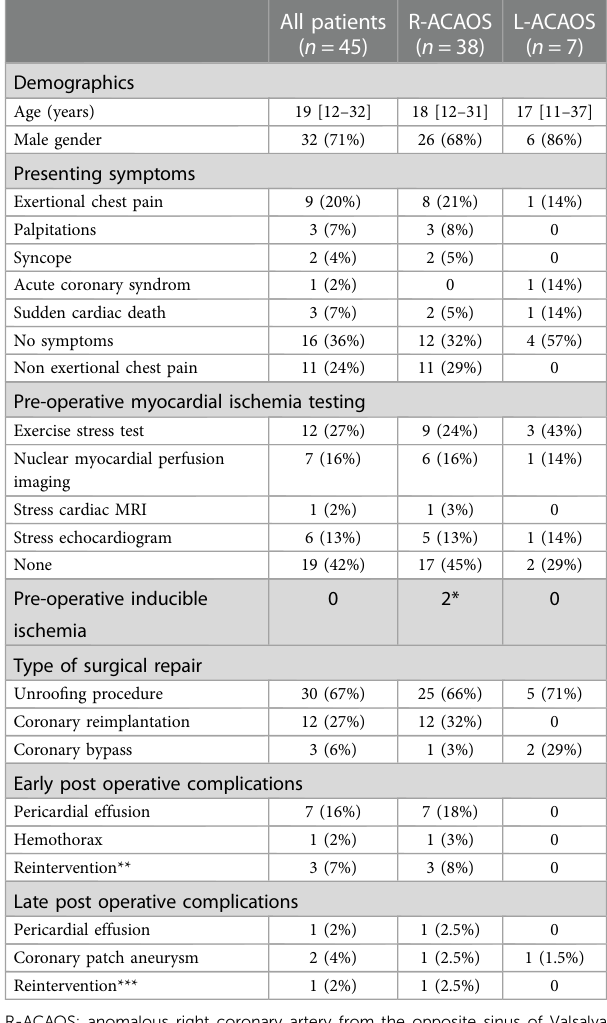
TABLE 1 Characteristics of the study